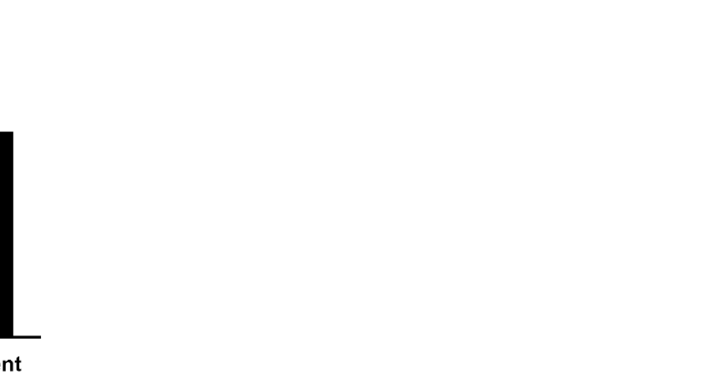
Figure 4. Superoxide anion production in controls and heart transplanted patients. Values are means ± SEM, *: p < 0.05, n = 20 in control and 19 in Htx group.